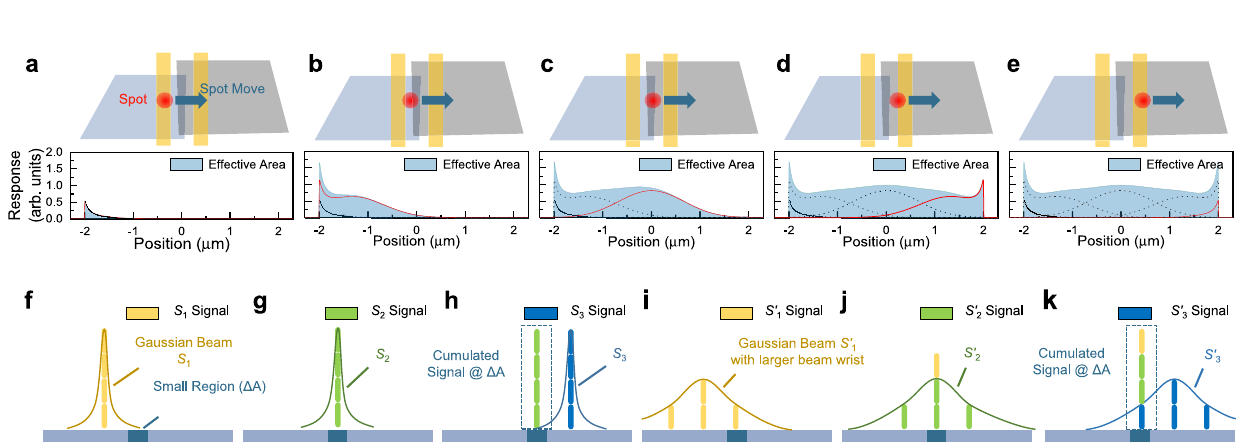
Fig. 2 | Characterizing the effective area by the scanning photocurrent map- ping. a – e Photocurrent mapping illustration of the distribution of the response with beam centered at different positions with optical responses shown in Fig. 1g. f – k Illustration of cumulated mapping signal with different beam wrist. S 1 , S 2 , and S 3 in f – h are scanning photocurrent signals of Gaussian beam with beam wrist